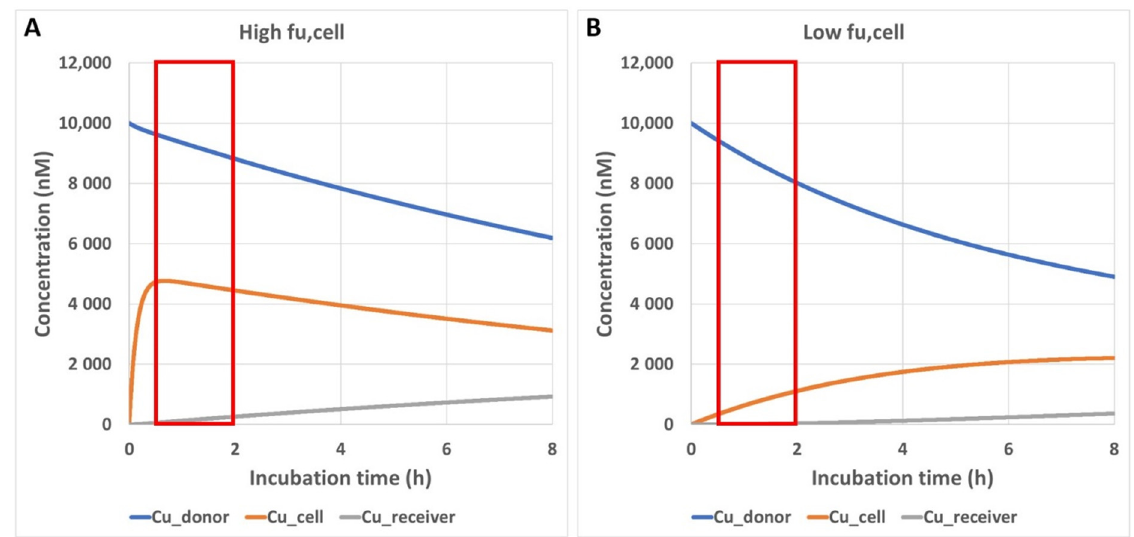
Figure 3. Simulated time course of the unbound compound concentrations in the donor compartment ( C u_donor ), in the cells ( C u_cell ), and in the receiver compartment ( C u_receiver ) in a permeability assay. Red boxes indicate the incubation period in the standard permeability assay which starts after 30 min of preincubation. Details of the model are described in Section 2.6. ( A ) f u,cell = 5%; ( B ) f u,cell = 0.1%.